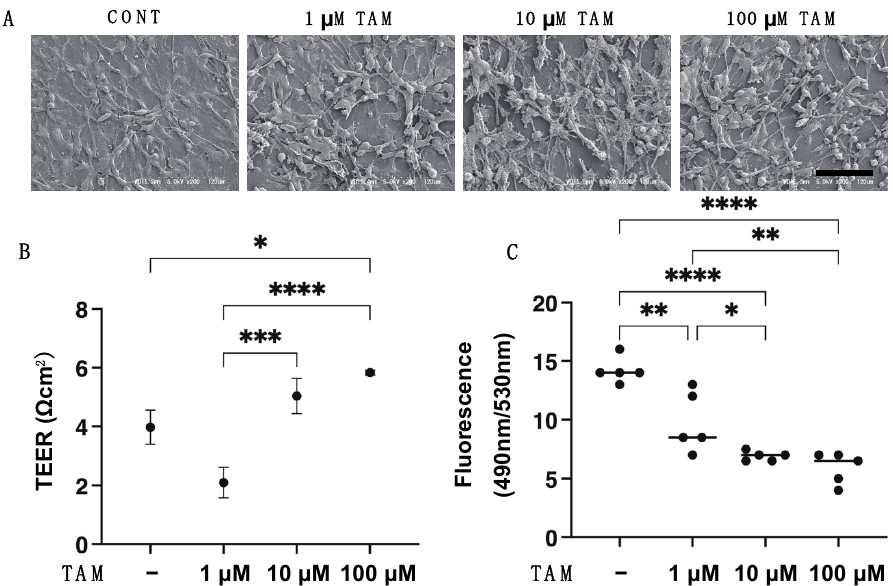
Figure 1. Effects of different concentrations of tamsulosin (TAM) on ( A ) ultrastructure by scanning electron microscopy (SEM), ( B ) transepithelial electrical resistance (TEER) and ( C ) FITC-dextran permeability of an ARPE 19 monolayer. Ultra-structure and barrier functions of an ARPE 19 cells monolayer obtained by their 2D culture at Day 5 in the absence or presence of 1 µ M, 10 µ M or 100 µ M tamsulosin (TAM) were analyzed. Representative images by scanning electron microscopy (SEM, scale bar; 100 µ m) are shown in panel A, and transepithelial electrical resistance (TEER) values and FITC-dextran permeability were plotted at panels ( B , C ), respectively. All experiments were performed in duplicate using fresh preparations ( n = 5). Data are presented as arithmetic means ± standard error of the mean (SEM). * p < 0.05, ** p < 0.01, *** p < 0.005, **** p < 0.001 (ANOVA followed by a Tukey’s multiple comparison